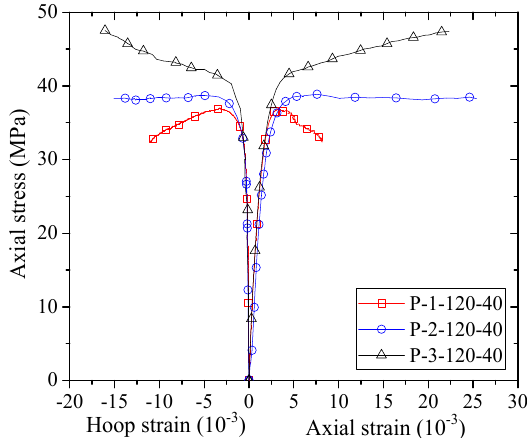
Figure 10. Stress–strain curves of concrete in the Group IV specimens.